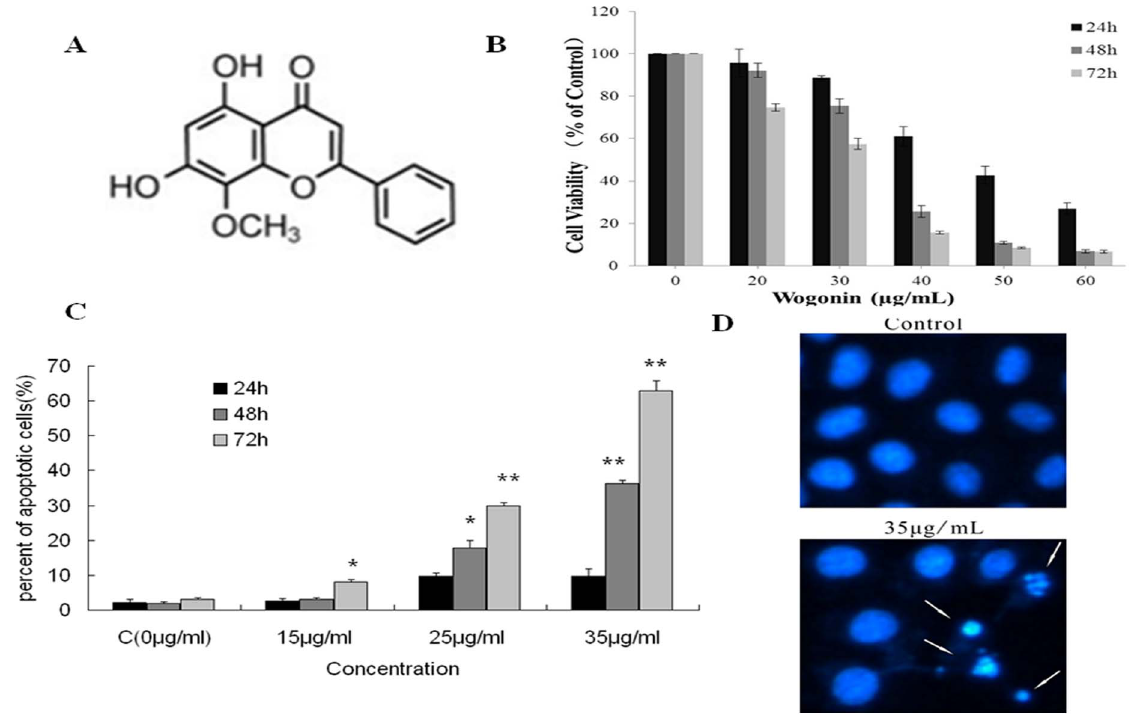
Figure 1. Chemical structure of wogonin and wogonin exerted potent anti- A549 activity invitro . (A) Chemical structure of wogonin (C 16 H 12 O 5 , MW: 284.27). (B) Cell viability was analyzed using the MTT assay. Cells were incubated with wogonin for 24 h, 48 h or 72 h. The bars represent the mean values 6 SEM (n=3). (C) Apoptosis assessed by Annexin V/PI staining in A549 cells. Cells were incubated with wogonin at concentrations of 0, 15, 25, 35 m g/mL, for 24 h, 48 h and 72 h. (D) Nuclei stained by DAPI and observed by fluorescence microscope. Apoptotic cells are indicated by arrows. * P , 0.05 vs control group, ** P , 0.01 vs control